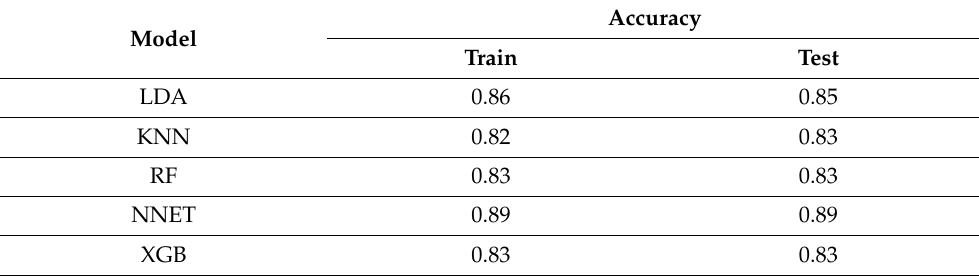
Table 4. Layer-2 Models Performance (4-Bus System).